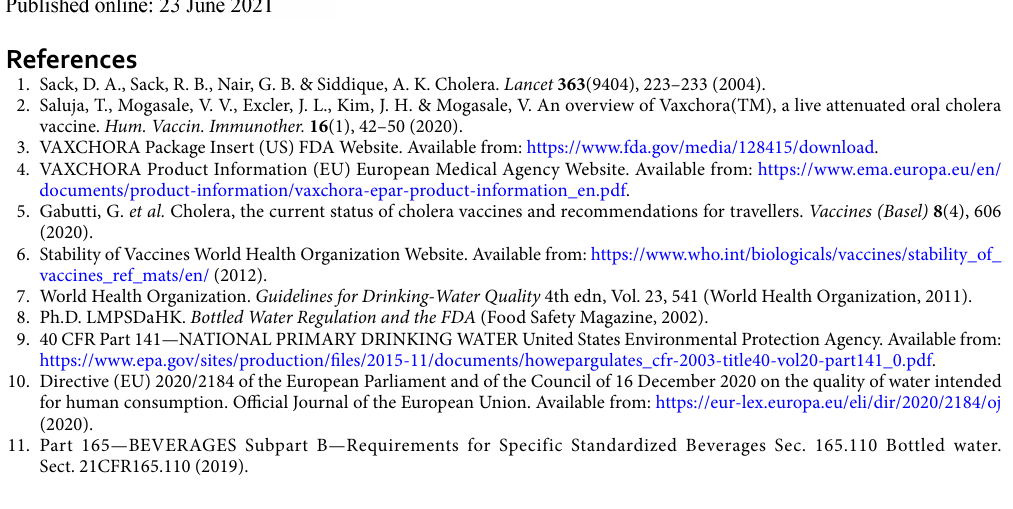
Table 7. Geometric mean CFUs and 95% confidence intervals by type of bottled water over time (2016, 2019).